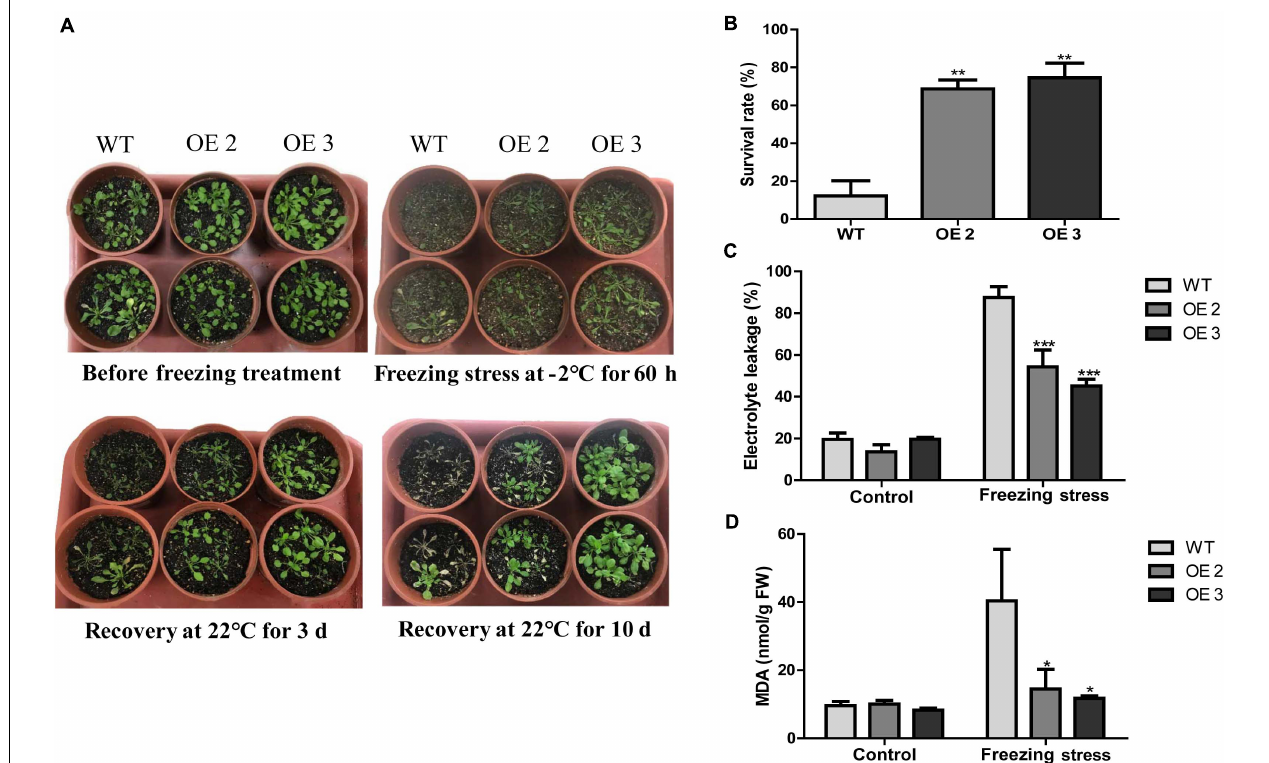
FIGURE 4 | Overexpression of HcTOE3 confers freezing tolerance in Arabidopsis . (A) Phenotype of the HcTOE3- overexpressing plants and the non-transgenic controls under freezing stress. (B) Survival rates were counted from 46 biological replicates. (C) Electrolyte leakage. (D) MDA content. Data represented the average of three biological replicates. Significant differences at * p < 0.05, ** p < 0.01, and *** p <